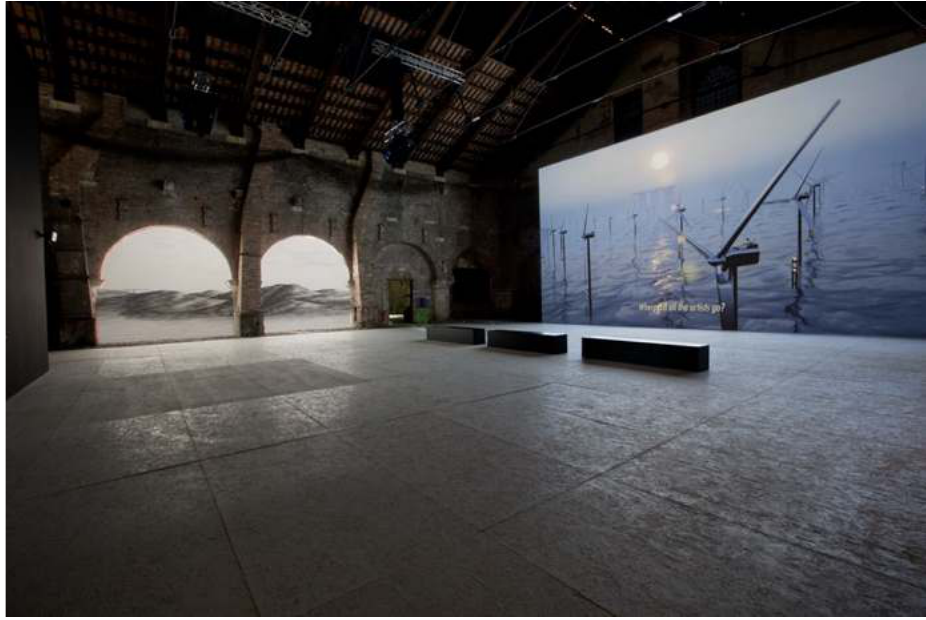
Photo by Vinciane